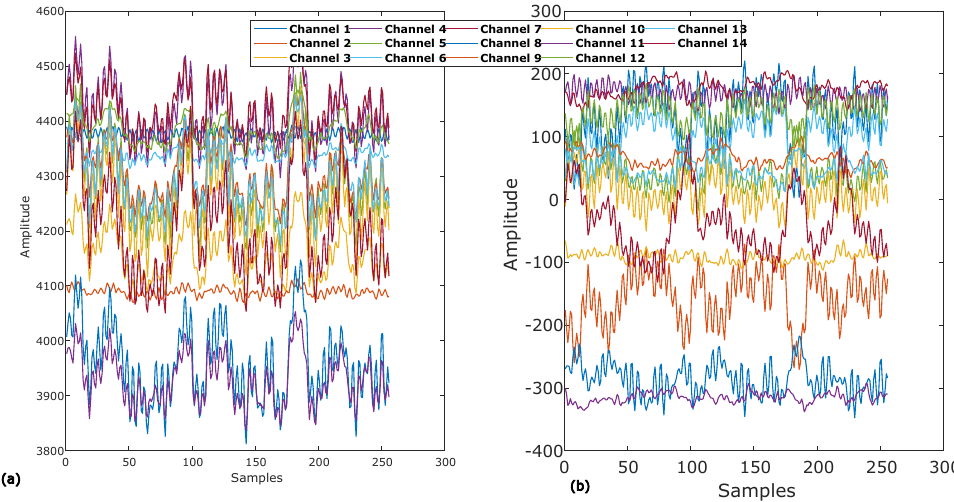
Figure 3. ( a ) Raw EEG signals of 14 channels. ( b ) EEG Signals of 14 channels averaged to common